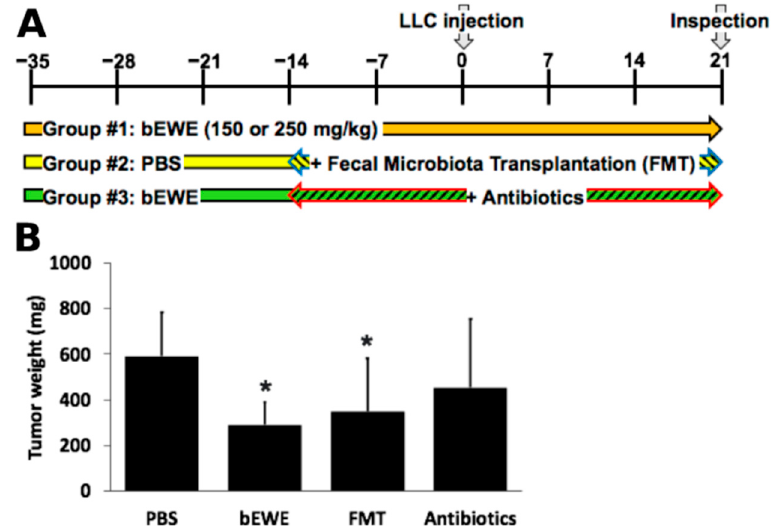
Figure 5. Fecal microbiota transplantation (FMT) from bEWE treated mice significantly attenuated the growth of tumors in the murine lung. ( A ) Schematic illustration of the study design. ( B ) Average tumor weight in each treatment group. PBS served as control. Results are presented as mean ± SD ( n = 5). *: p < 0.05 as compared to PBS-treated group.